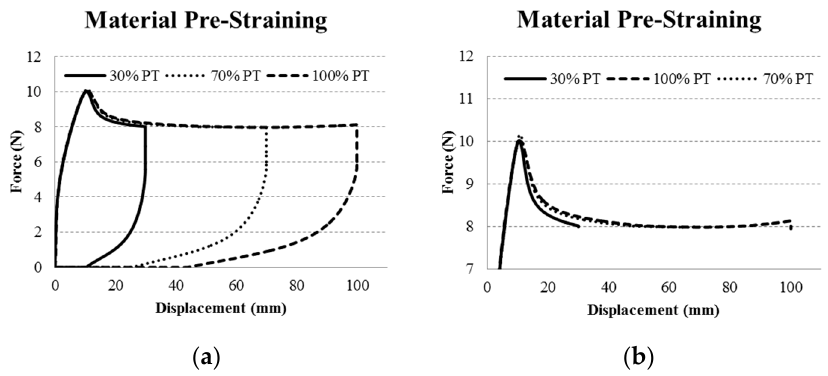
Figure 1. Pre-tension ribbon material evaluation, showing that the material has a minimum force response around 60% ( a ), and begins to increase starting at 80% ( b ), indicative of strain hardening. A U-shaped cutting die (LSB Stanzformen AG Gunzgen, CH) was used to cut out the U form from the extruded sensor ribbon. The final sensor geometry had an arm width of ~2 mm, and a